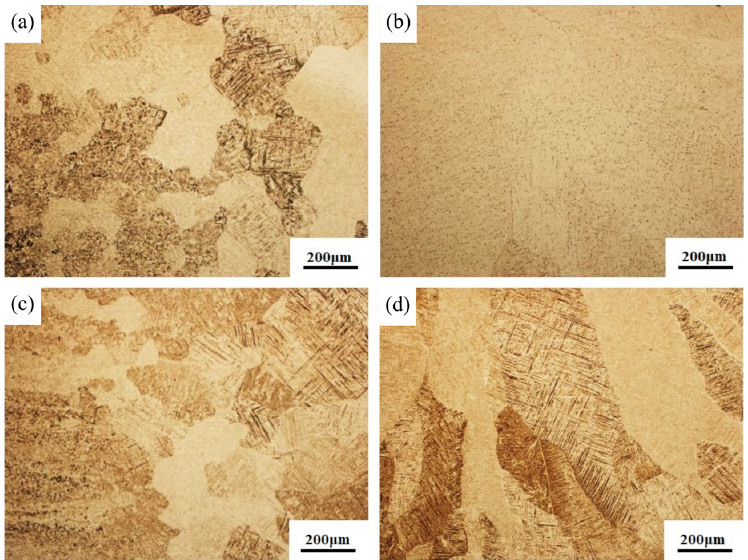
Figure 6. Microstructural comparison of the heat-affected zone and fusion zone: ( a ) HAZ of flux-cored wire welding joint; ( b ) FZ of flux-cored wire welding joint; ( c ) HAZ of cable wire welding joint; ( d ) FZ of cable wire welding joint.